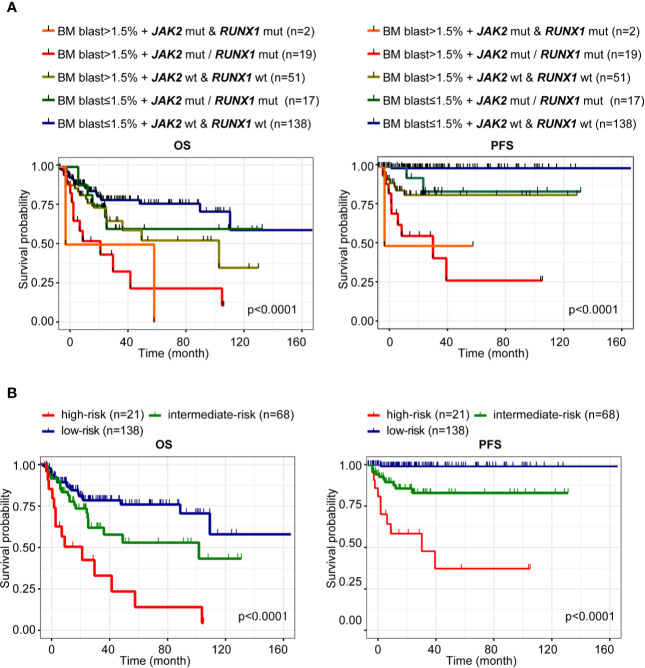
Prediction of prognosis of LR-MDS. (A) Kaplan-Meier curves for OS and PFS according to BM blast (%) and mutation status of JAK2 and RUNX1 of patients with LR-MDS. (B) Kaplan-Meier curves for OS and PFS of the following three subgroups: low-risk subgroup (BM blast ≤1.5% without JAK2 and RUNX1 mutation), intermediate-risk subgroup (BM blast ≤1.5% with JAK2 or RUNX1 mutation, BM blast >1.5% without JAK2 and RUNX1 mutation), and high-risk subgroup (BM blast >1.5% with JAK2 and/or RUNX1 mutation).